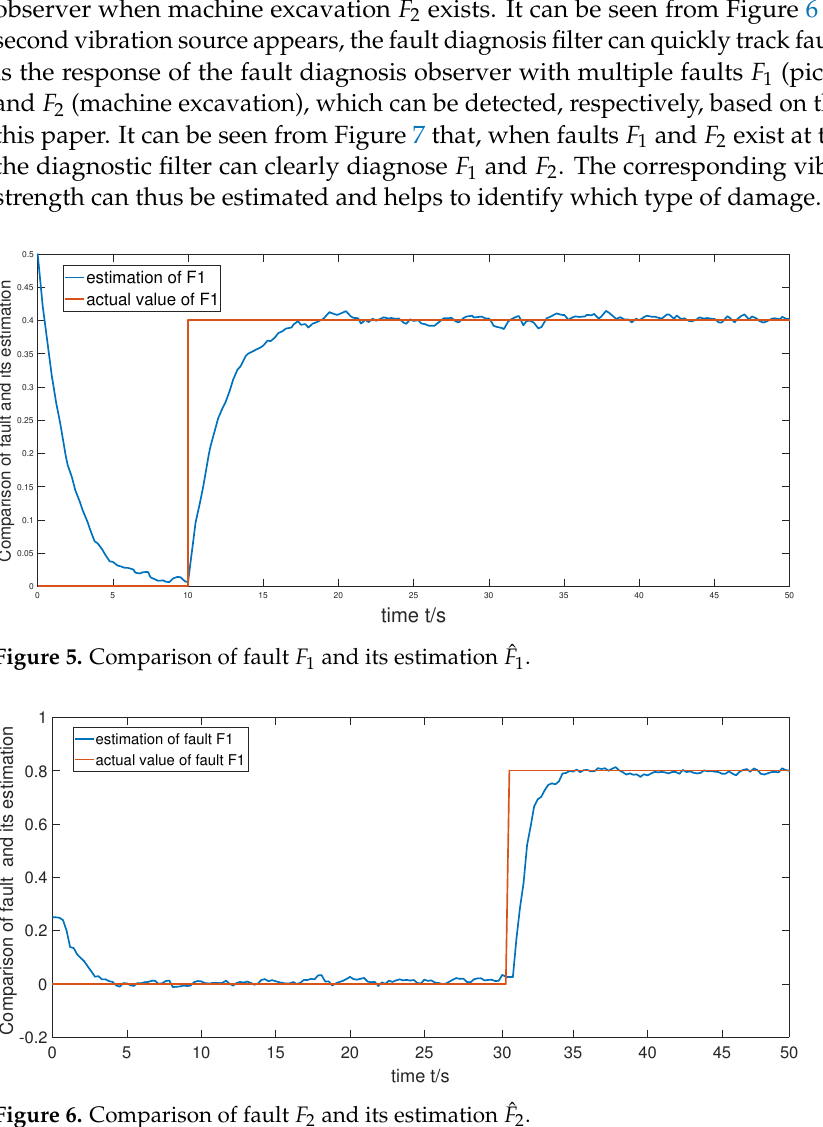
Figure 6. Comparison of fault F 2 and its estimation ˆ F 2